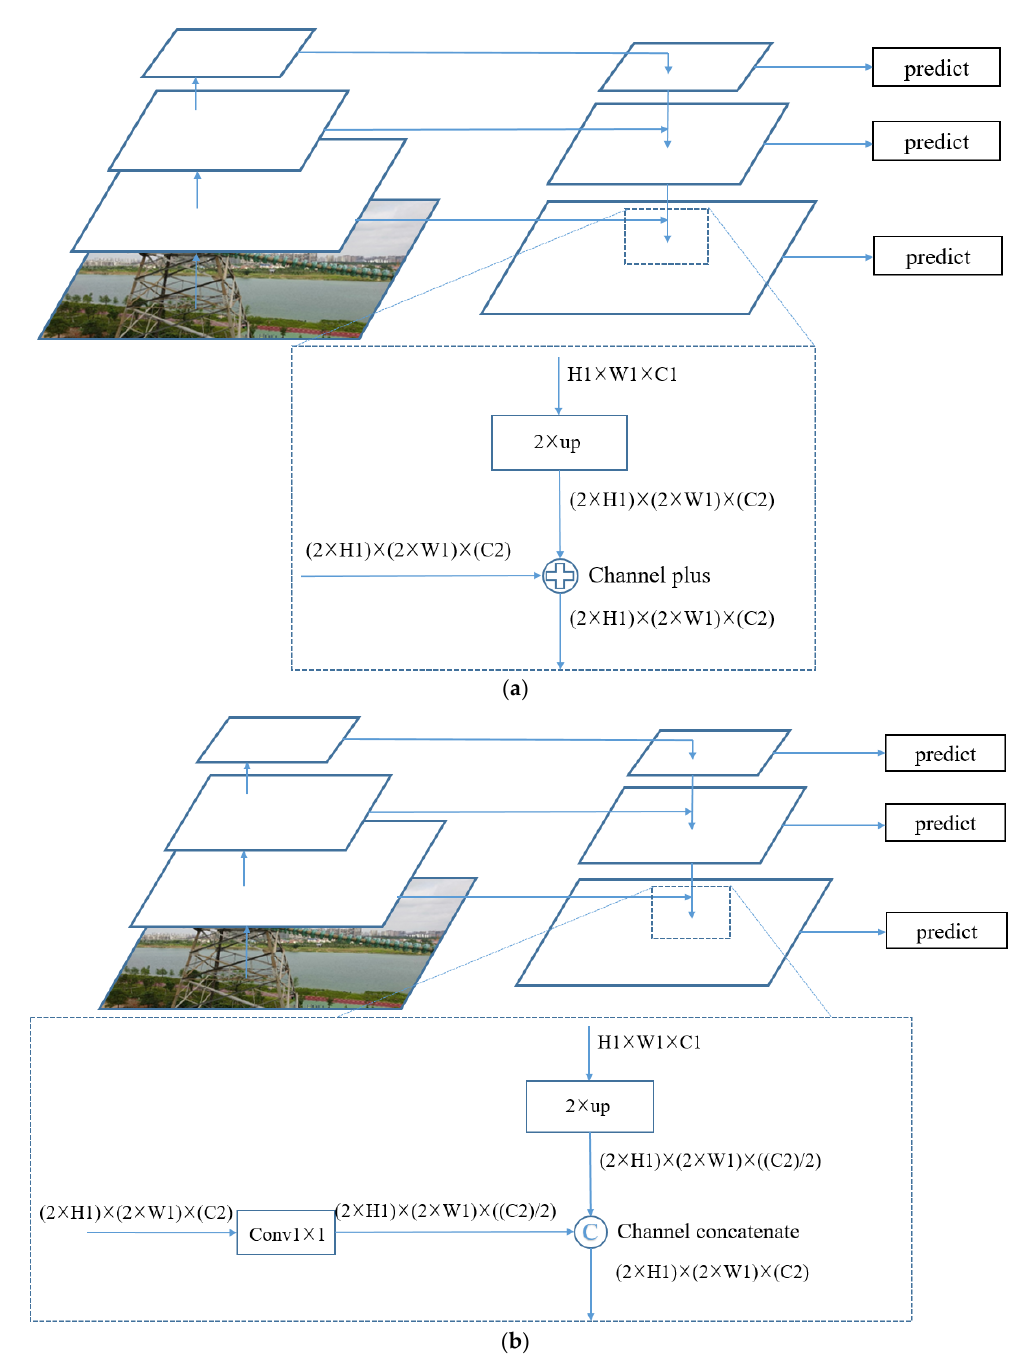
Figure 5. Neck: ( a ) Channel plus; ( b ) Channel